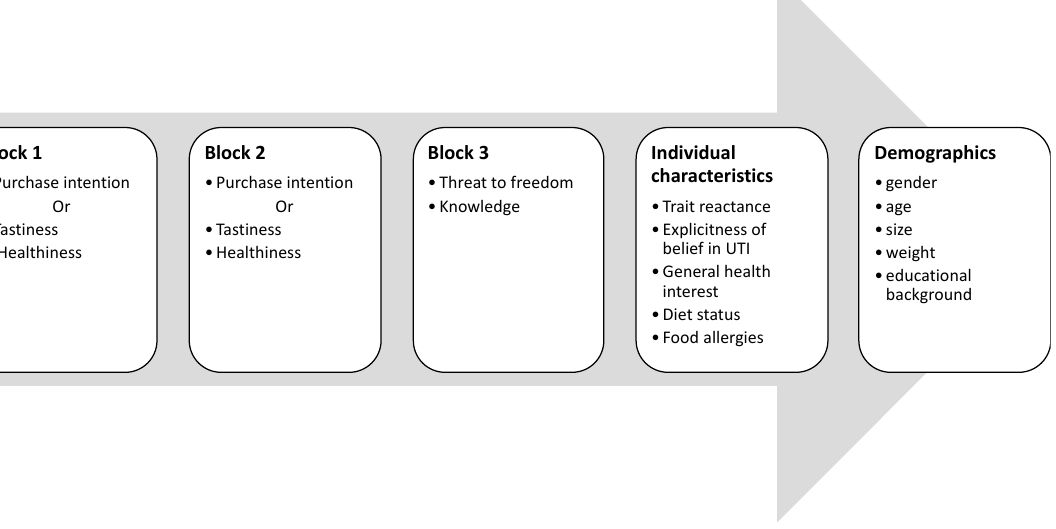
Figure 2. Overview of the experimental procedure. Note that each of the first three blocks consisted of 20 stimulus pictures, presented and rated one after another in random order. The procedure was the same for participants in both conditions.